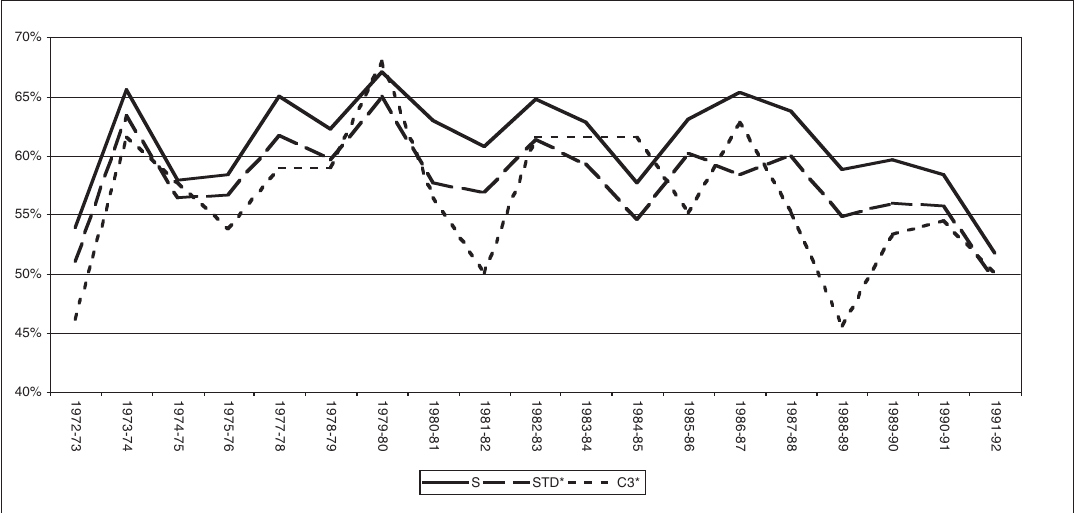
Figura 2 – L’indice sorpresa ( S ) messo a confronto con la deviazione standard ( STD* ) e il rapporto di concentrazione ( C 3 *